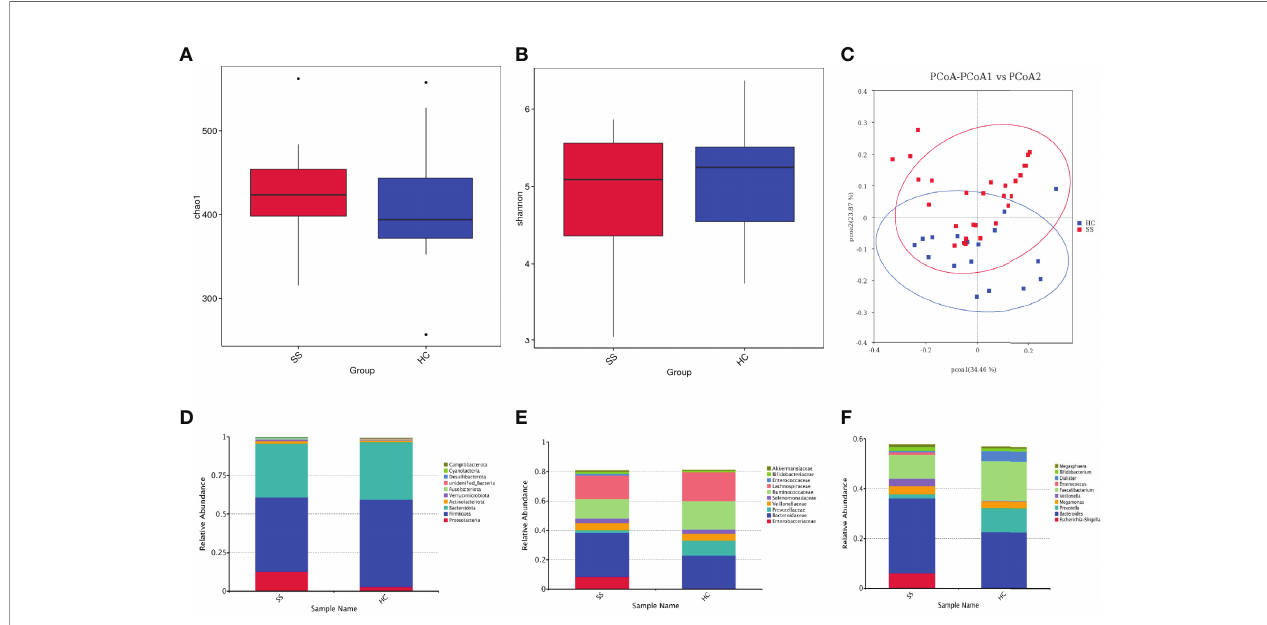
FIGURE 1 | The gut microbiota of pSS patients differs from that of HCs and taxonomic proportions according to the compositions of the phyla, families and genera of pSS patients and HCs. (A) Chao 1 index of pSS patients and HCs. (B) Shannon diversity index of pSS patients and HCs. (C) Beta diversity of the genera analyzed by weighted UniFrac PCoA. (D) Taxonomic proportions according to compositions at the phylum level. (E) Taxonomic proportions according to compositions at the family levels. (F) Taxonomic proportions according to compositions at the genus